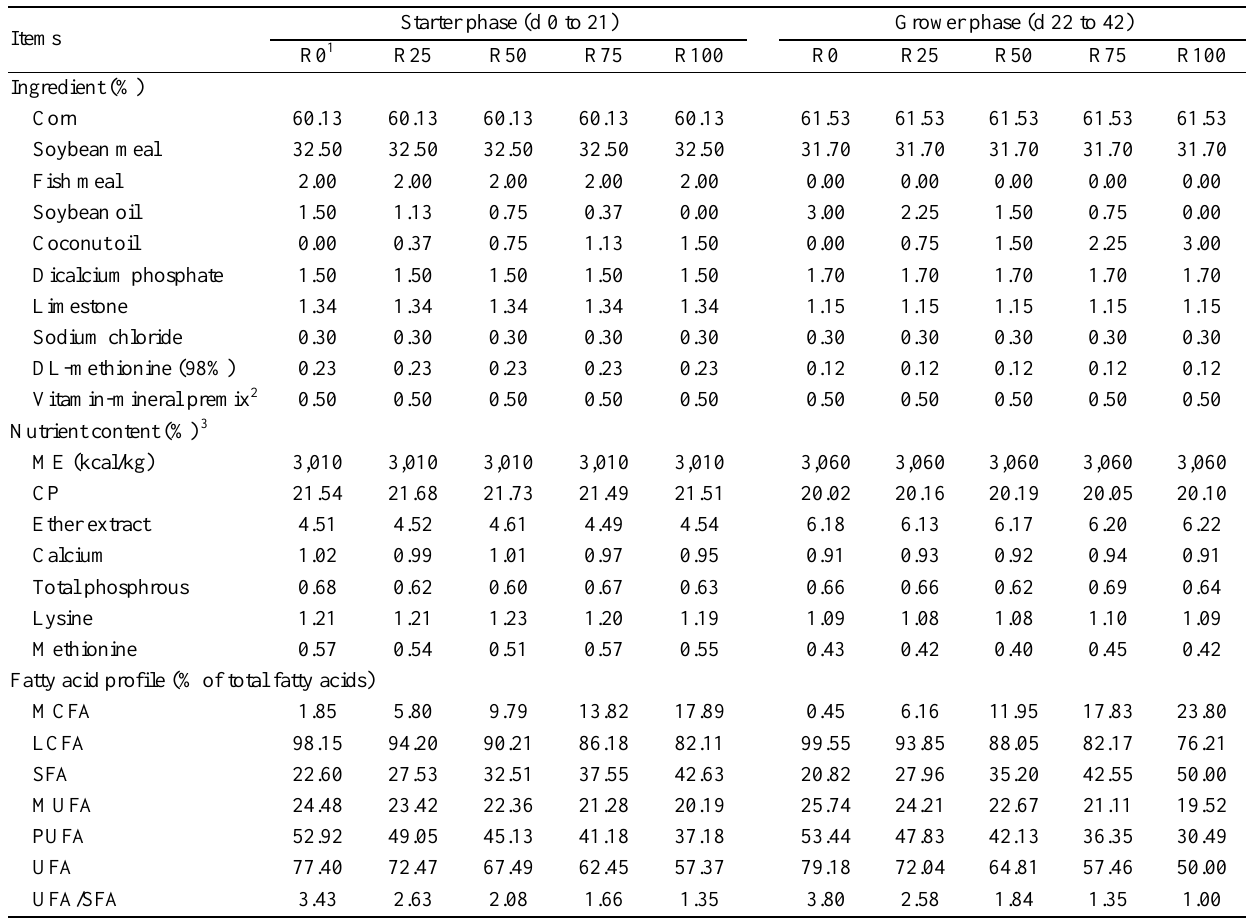
Table 1. Ingredient composition and nutrient content of diets (% as fed)